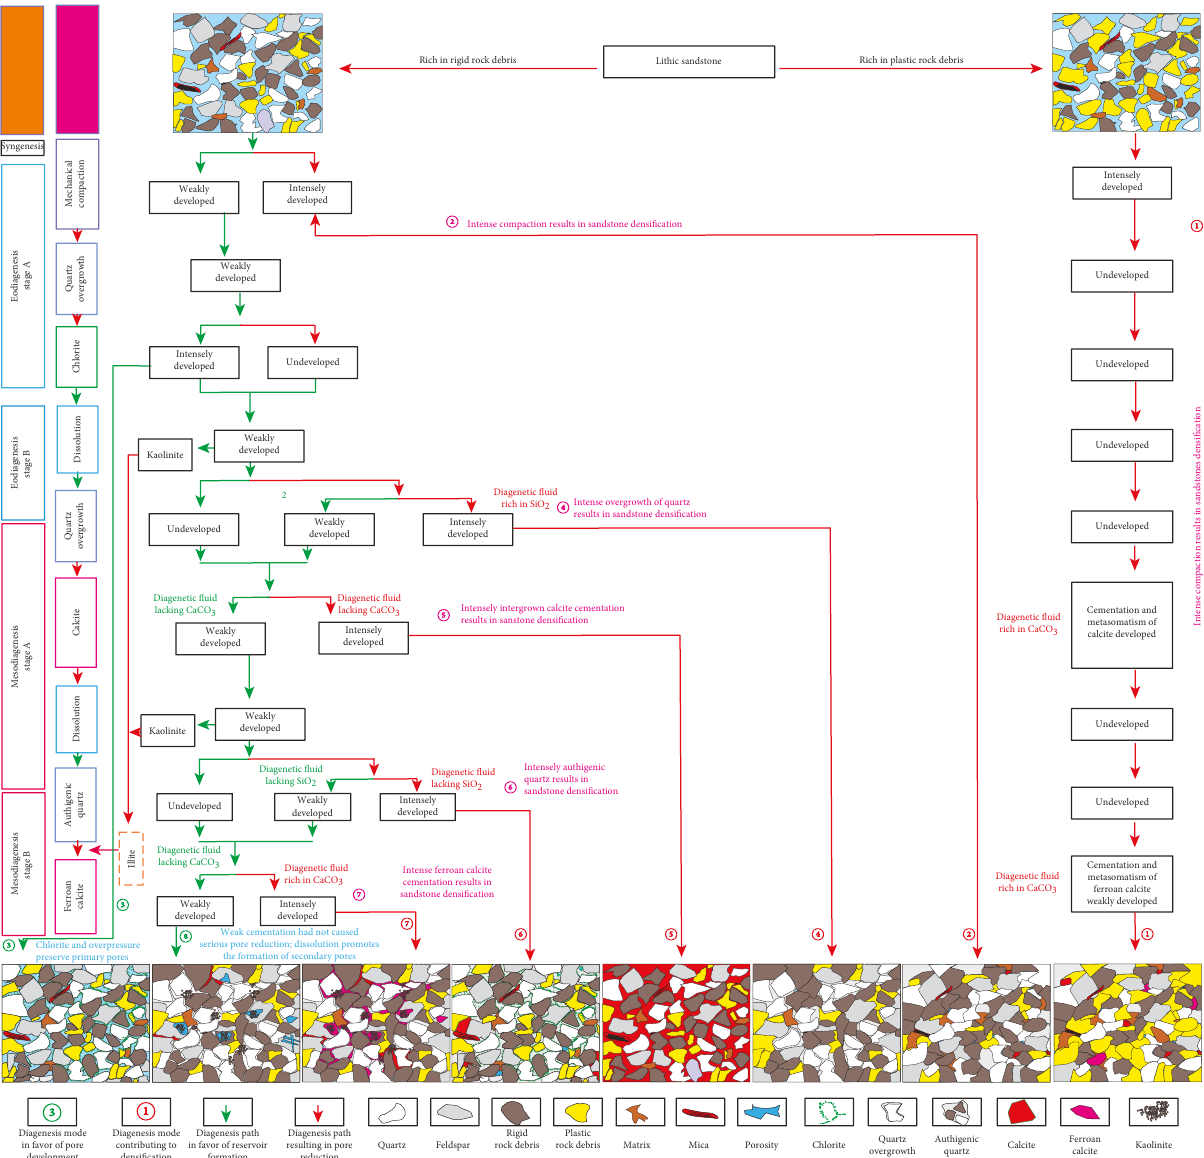
Figure 14: Diagenetic evolution pathways for various lithologic